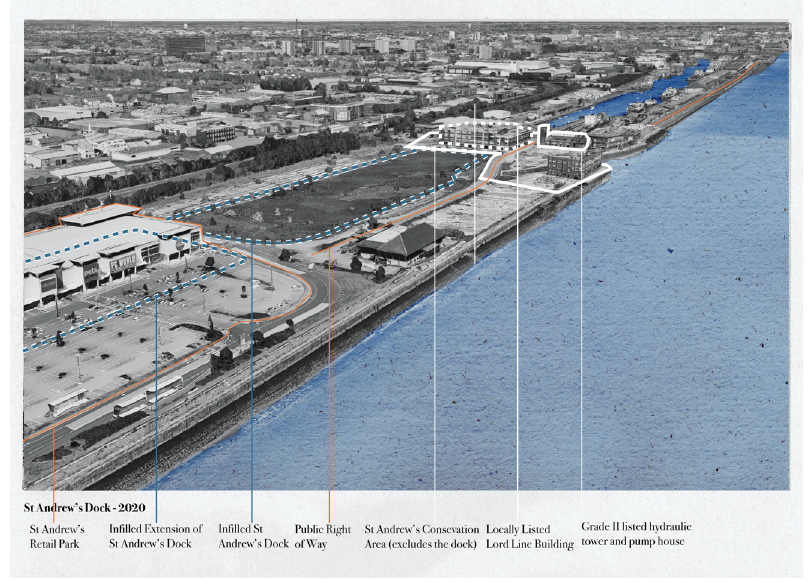
Annotated aerial view of St Andrew’s Dock. Adapted from ©2020